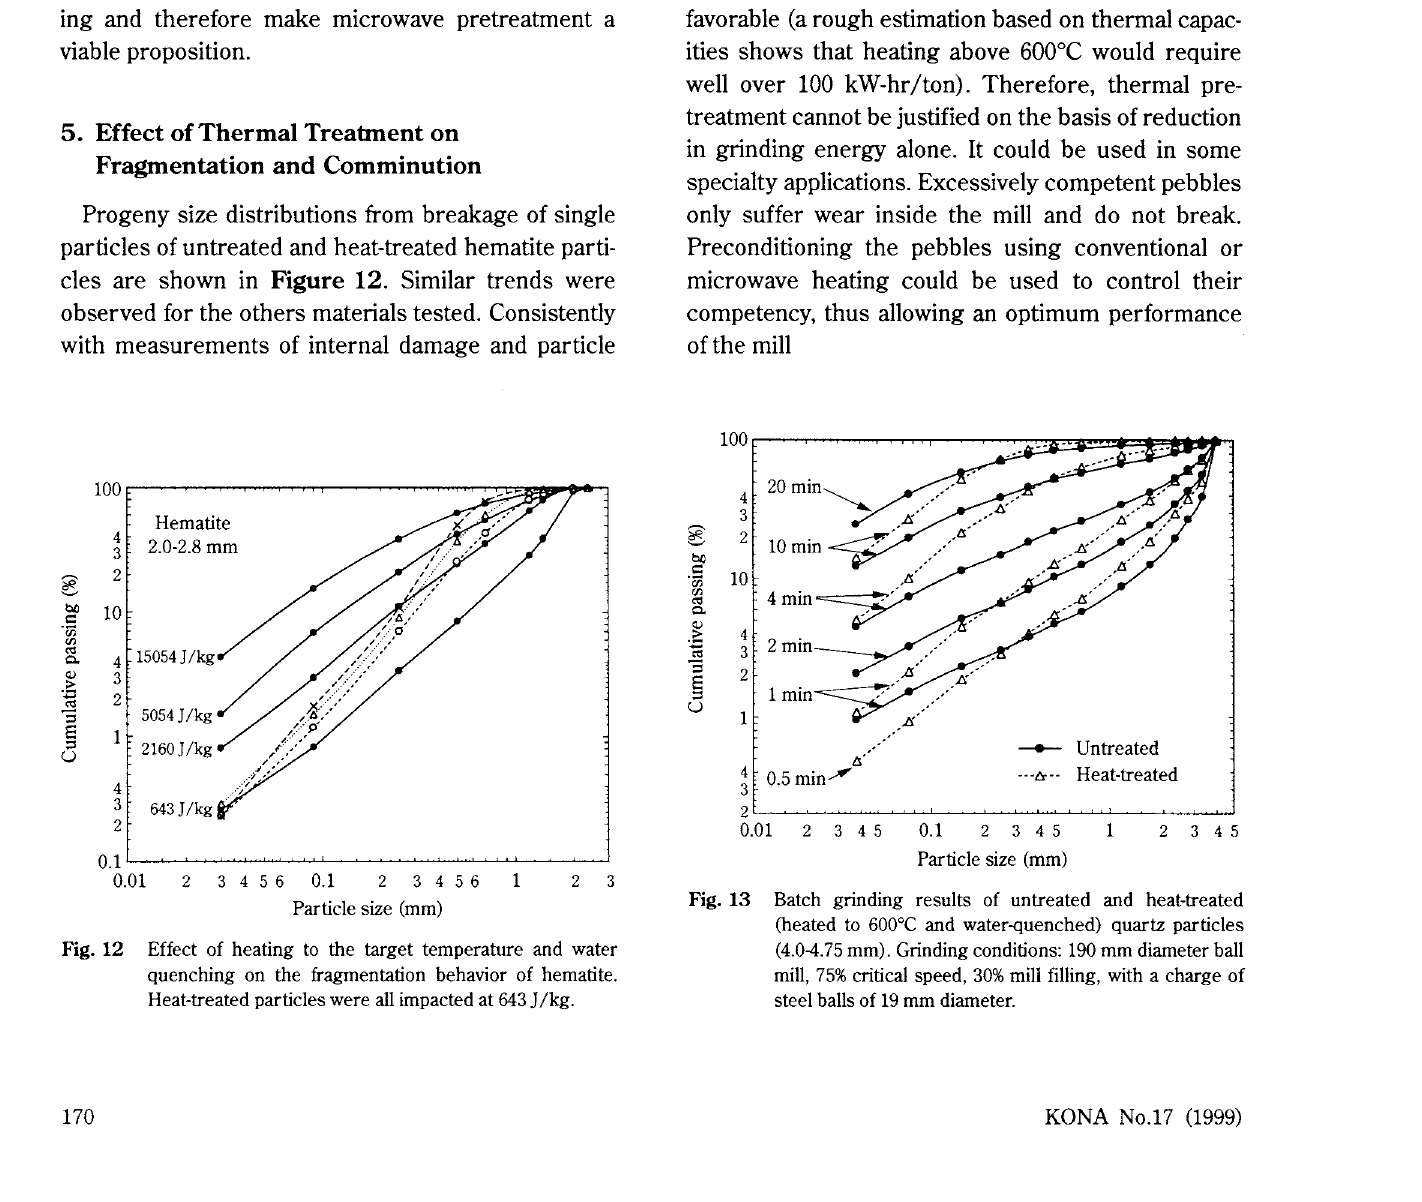
Fig. 13 Batch grinding results of untreated and heat-treated (heated to 600°C and water-quenched) quartz particles (4.0-4.75 mm). Grinding conditions: 190 mm diameter ball mill, 75% critical speed, 30% mill filling, with a charge of steel balls of 19 mm